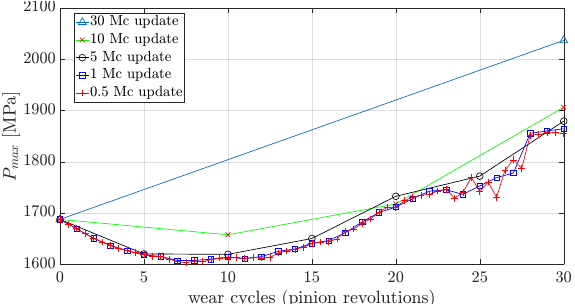
Figure 19. Maximum contact pressure from wear simulations with different geometry update frequencies.